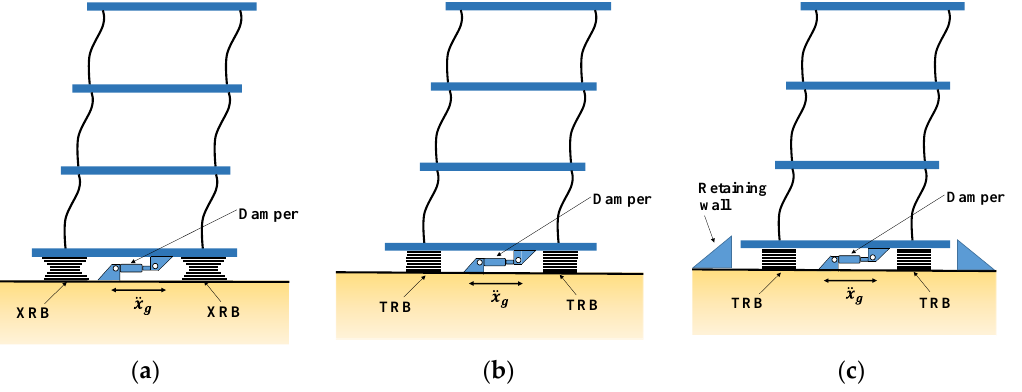
Figure 2. Schematic diagram of isolated buildings using: ( a ) XRBs; ( b ) TRBs; ( c ) TRBs with RWPs.